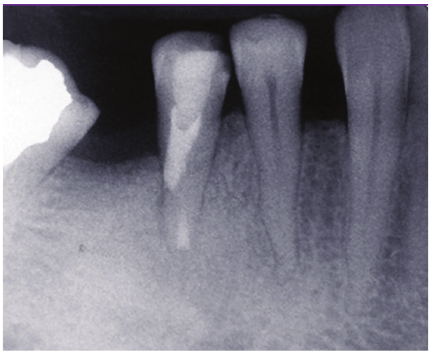
Figure 6: 12 months after intentional replantation, periapical radiolucency was noticeably reduced.